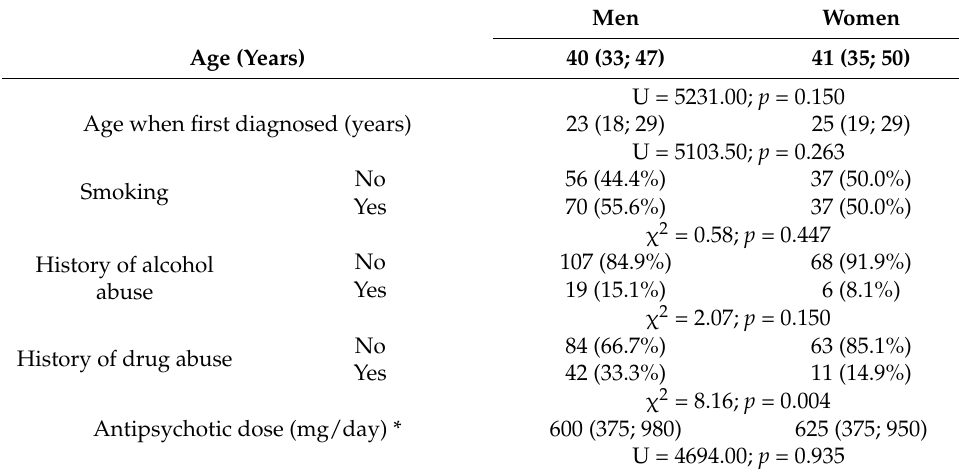
Table 1. Demographic and clinical data of patients with SCZ. Data are presented as a number (percentage) or median (Q1;